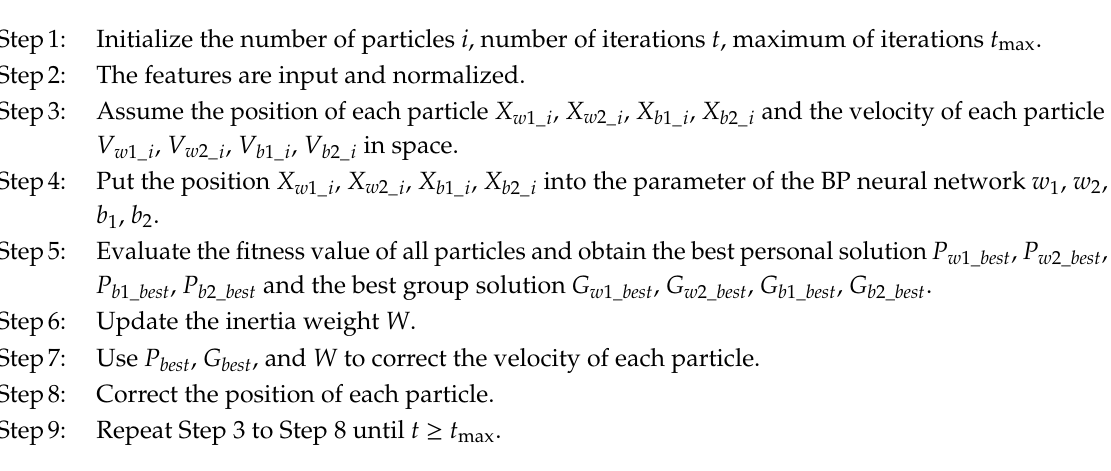
Figure 5. Flow chart of improved particle swarm optimization–back propagation (PSO-BP) neural